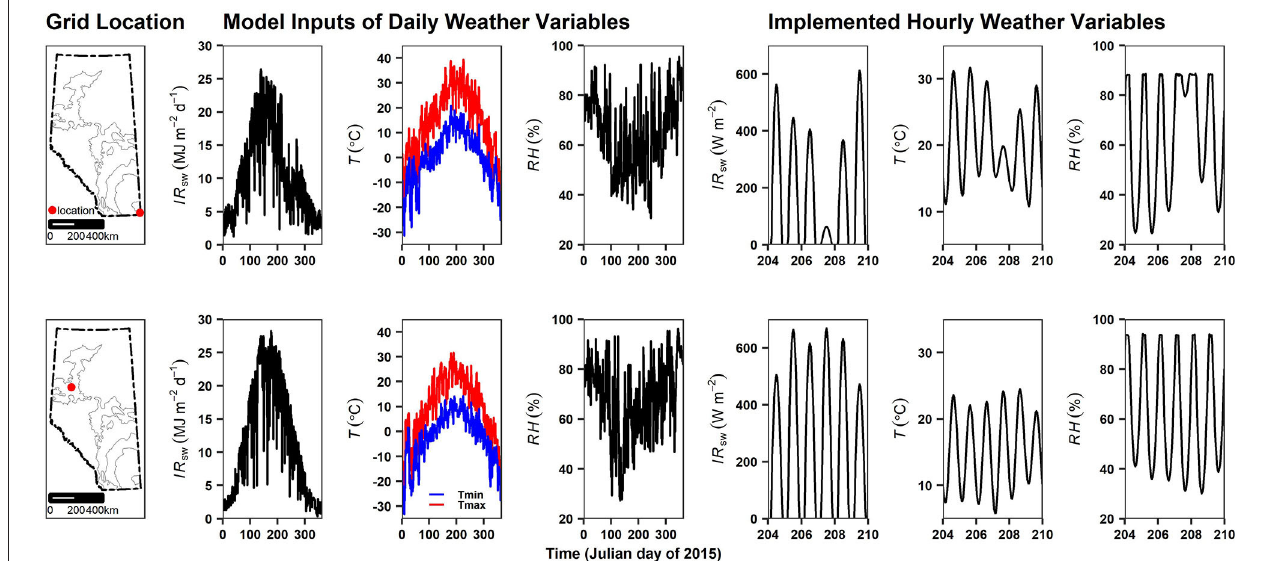
FIGURE 3 | Example representations of temporal downscaling of daily weather data to hourly weather variables to be implemented as hourly model inputs for vertical boundary conditions over two selected township grids using sinusoidal functions. IR sw , incoming shortwave radiation; T , air temperature; T min , daily minimum air temperature; T max , daily maximum air temperature; and RH, relative humidity. The thick dashed lines on the maps represent Alberta’s provincial boundary, and the thin black lines within the maps demarcate soil group